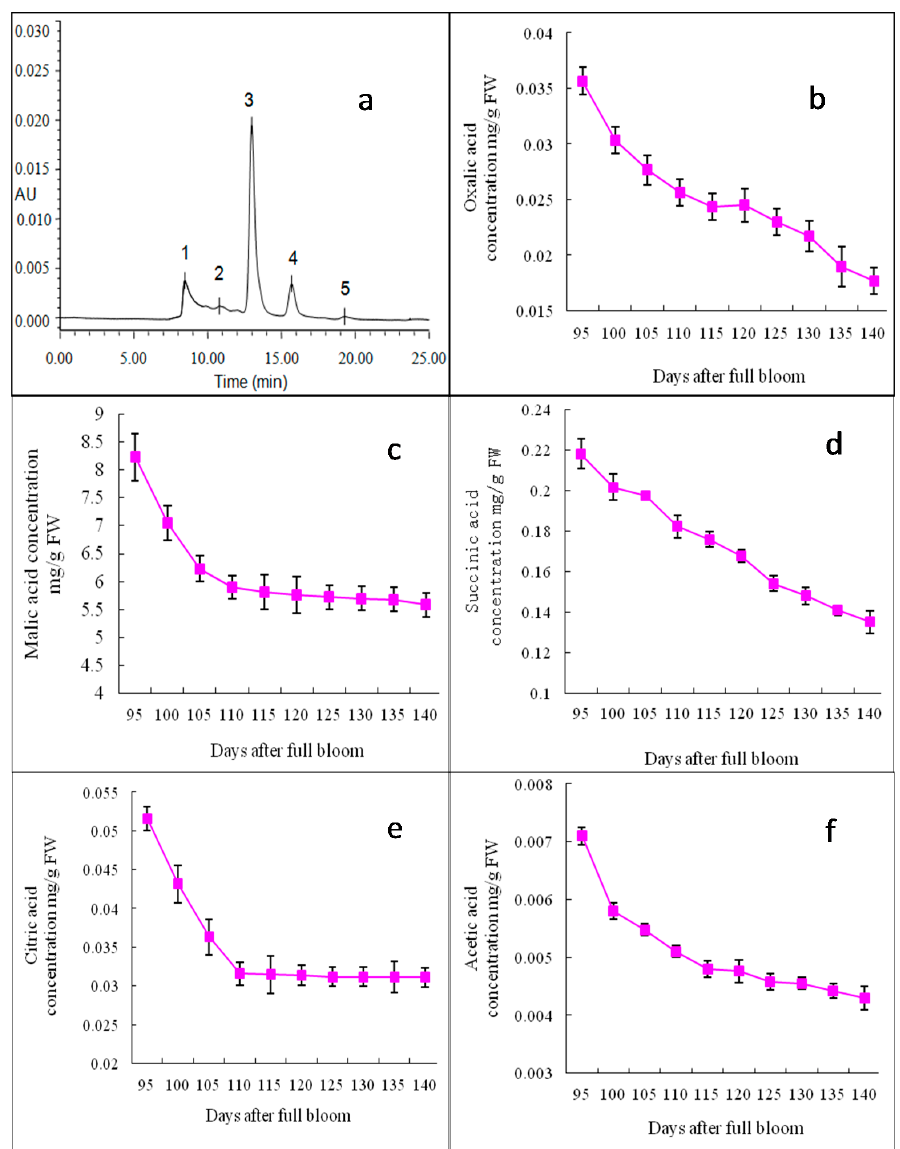
Figure 4. HPLC separation and concentration changes of organic acids in “Starkrimson” apple flesh during ripening period. ( a ) “Starkrimson” apple peel monitored by photo-diode array(PAD) detector. Peaks: 1 oxalic acid; 2 citric acid; 3 malic acid; 4 succinic acid; 5 acetic acid, and values are means ± SE ( n = 4); ( b – f ) concentration and changes of oxalic acid, citric acid, malic acid, succinic acid, 6 acetic acid in “Starkrimson” apple peel during ripening period.